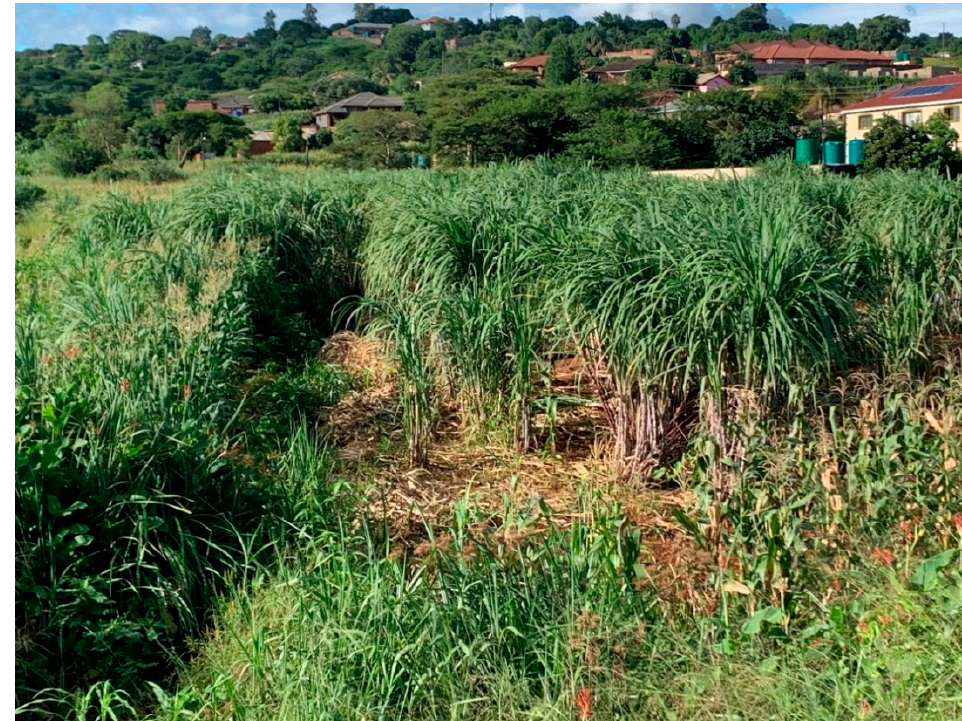
Figure 4. Sugarcane cultivated on wetlands in Thohoyandou.